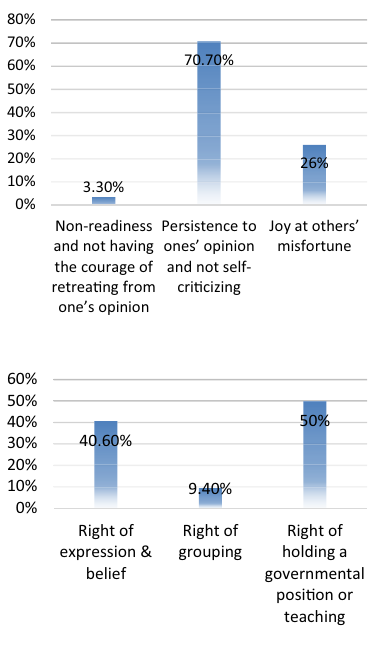
Figure 10. Denial of